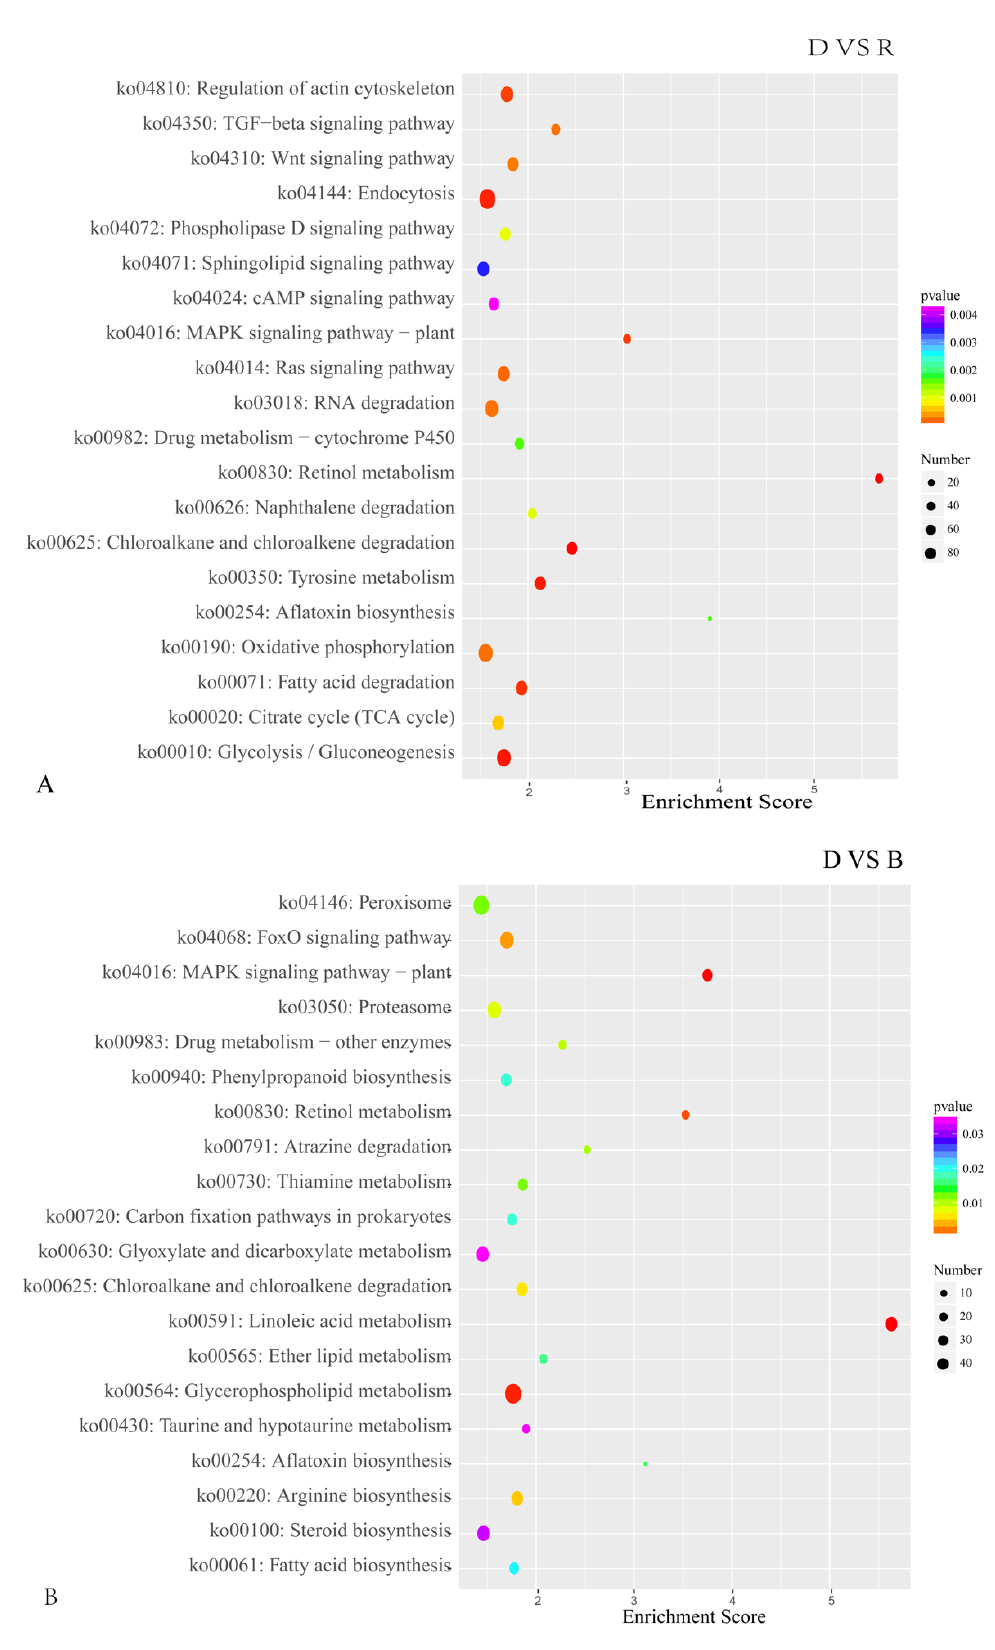
Figure 6. The top 20 enriched KEGG pathways of DEGs in primordium between blue or red light and darkness. ( A ). DEGs between D and R. ( B ). DEGs between D and B. The color intensity is proportional to the enrichment significance, and the circle size indicates the number of enriched genes.